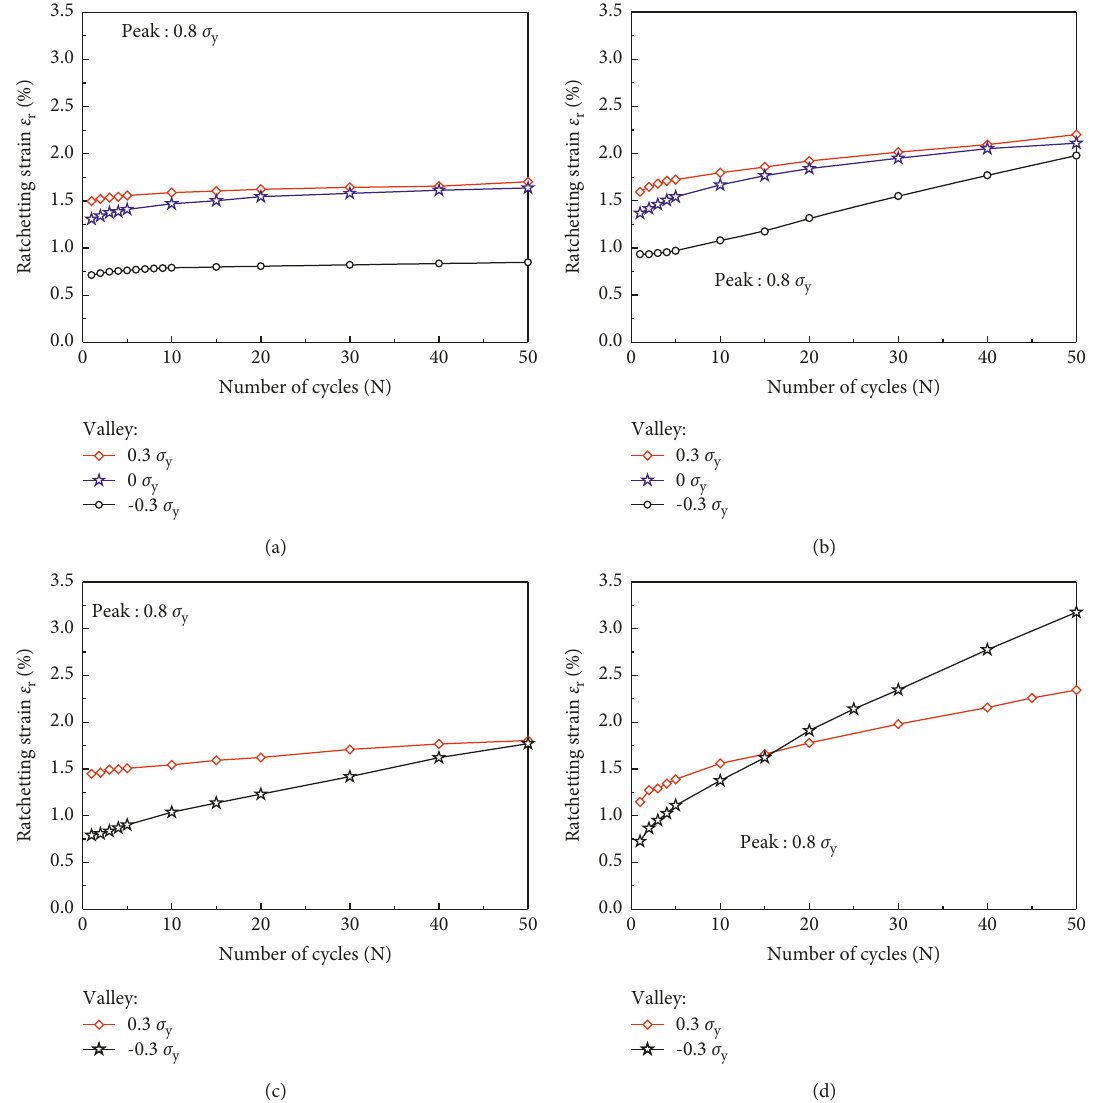
Figure 7: Ratchetting of PC in multiaxial stress-controlled cyclic tests under the rhombic-type 1 loading path and with different valley stresses at a constant peak stress of 0.8 × σ y and at various temperatures: (a) 35 ° C, (b) 60 ° C, (c) 75 ° C, and (d) 90 °